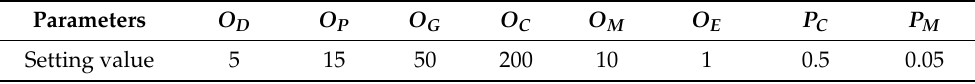
Table 5. Setting parameters.